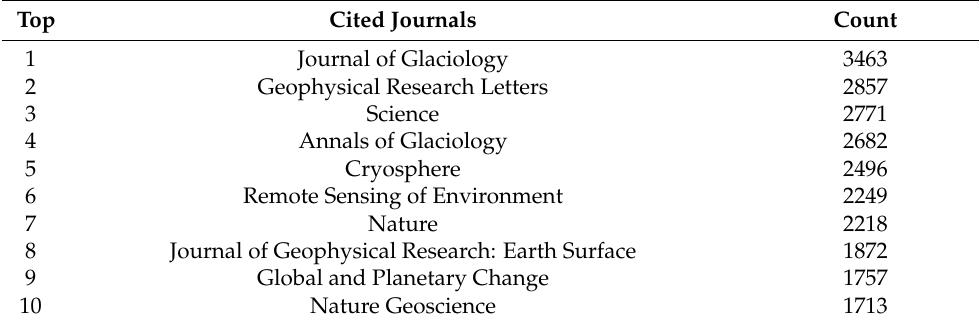
Table 2. Top 10 journals by citation.